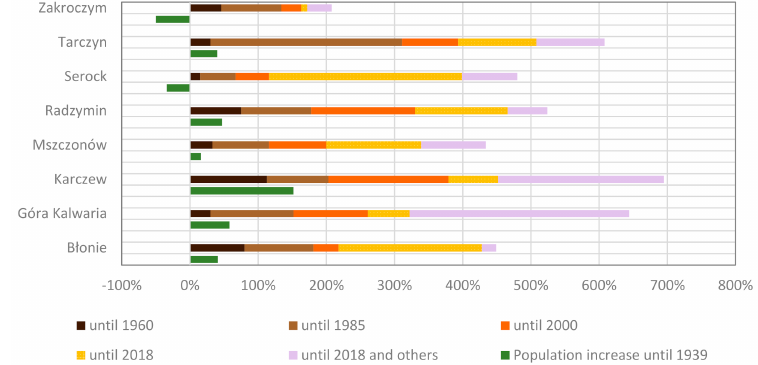
Figure 9. Increase in residential and commercial areas and other areas (industrial, recreational, military) and population since 1939. Source: own